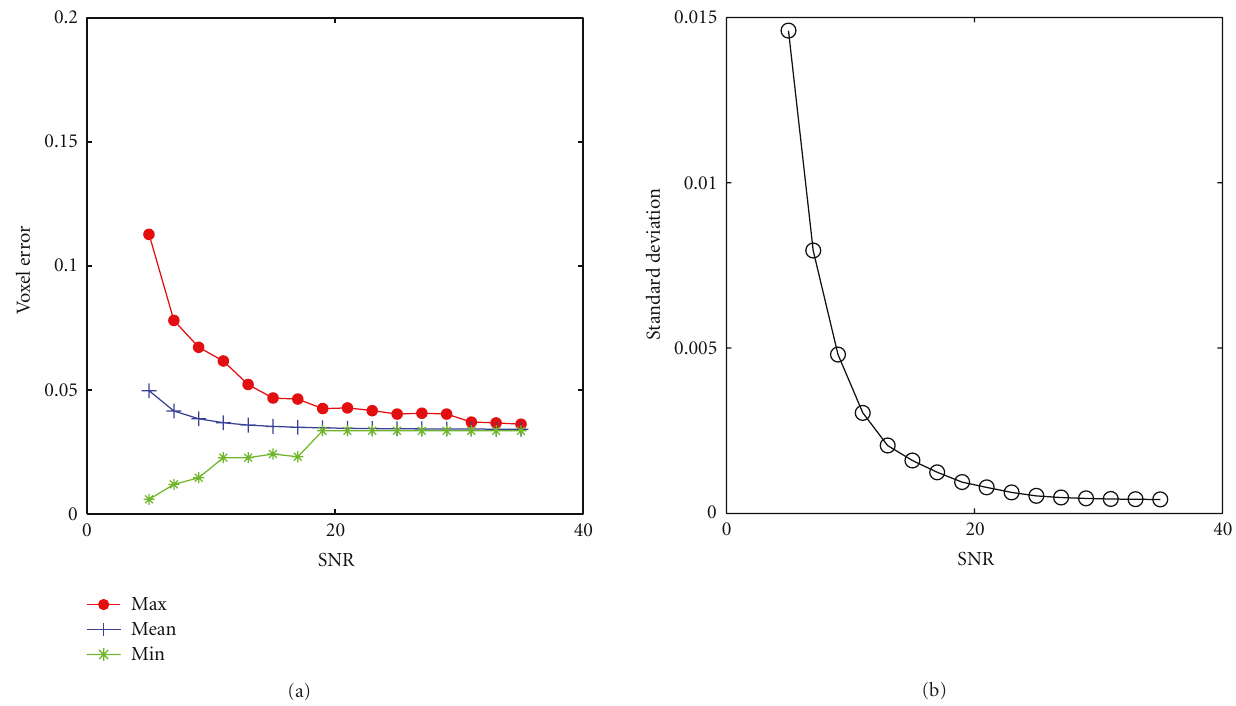
Figure 8: Results for SNR 5 up to 35 using T = 0 . 26. (a) The maximum (red dotted line), the mean (blue crossed line), and the minimum voxel error plotted against SNR, and (b) the standard deviation plotted against